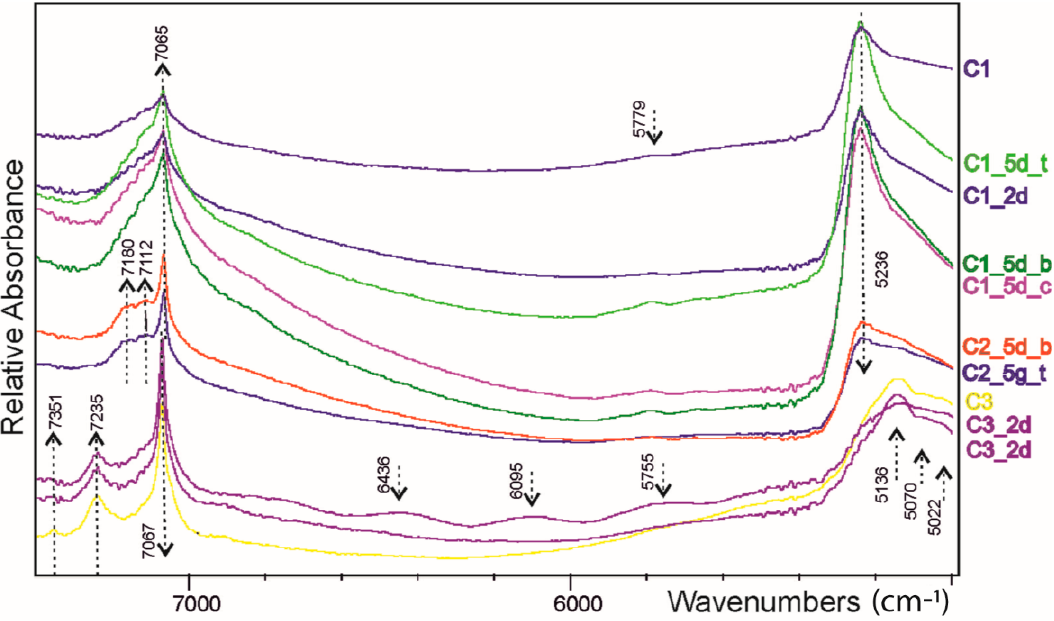
Figure 5. FT-IR spectra of C1, C2 and C3 samples in the 7400 – 5000 cm − 1 range by Integrating Sphere module with indication of main signals (vertical dotted lines with arrows). C1 and C3 are the original shale and carbonate samples, respectively; the remaining sample names indicate aliquots after experiments (2d and 5d for 2 days and 5 days of hydrothermal interaction, respectively). C1, C3 and C3_2d were analyzed as blocks. Table 2. XRF analysis (oxides weight %) of C1, C2 and C3 rock samples.